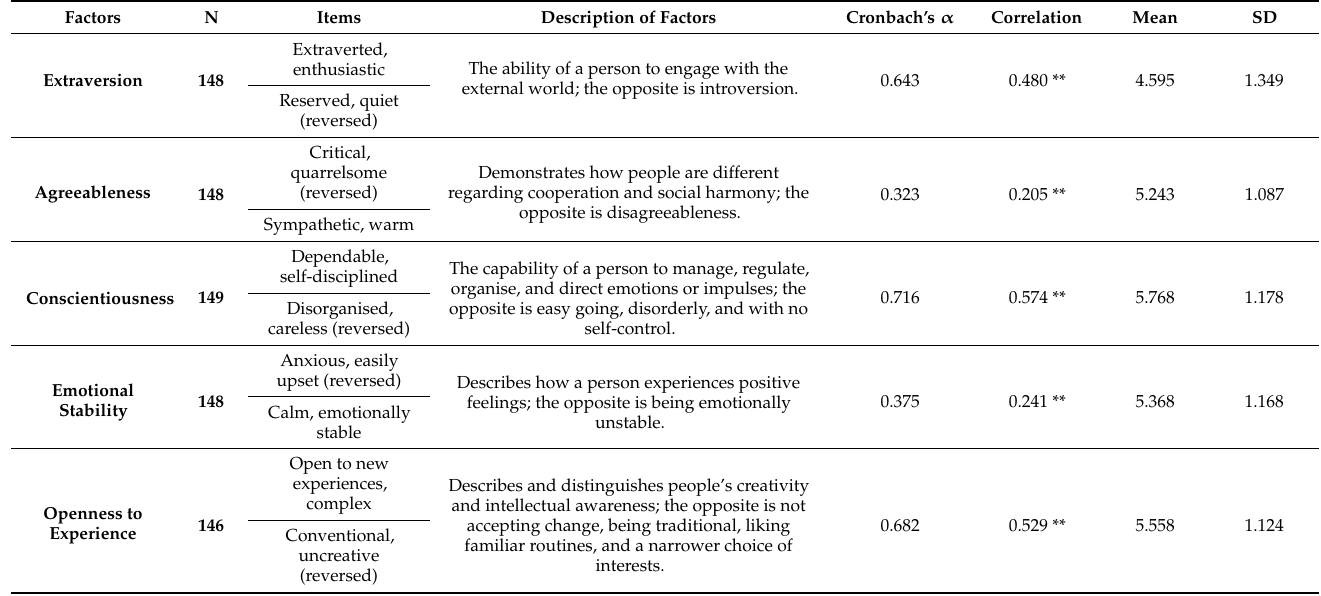
Table 3. The Big Five Personality traits (based on Payne and Harper (2020) and Gosling et al. (2003)). Description of Factors Cronbach’s α Correlation Mean